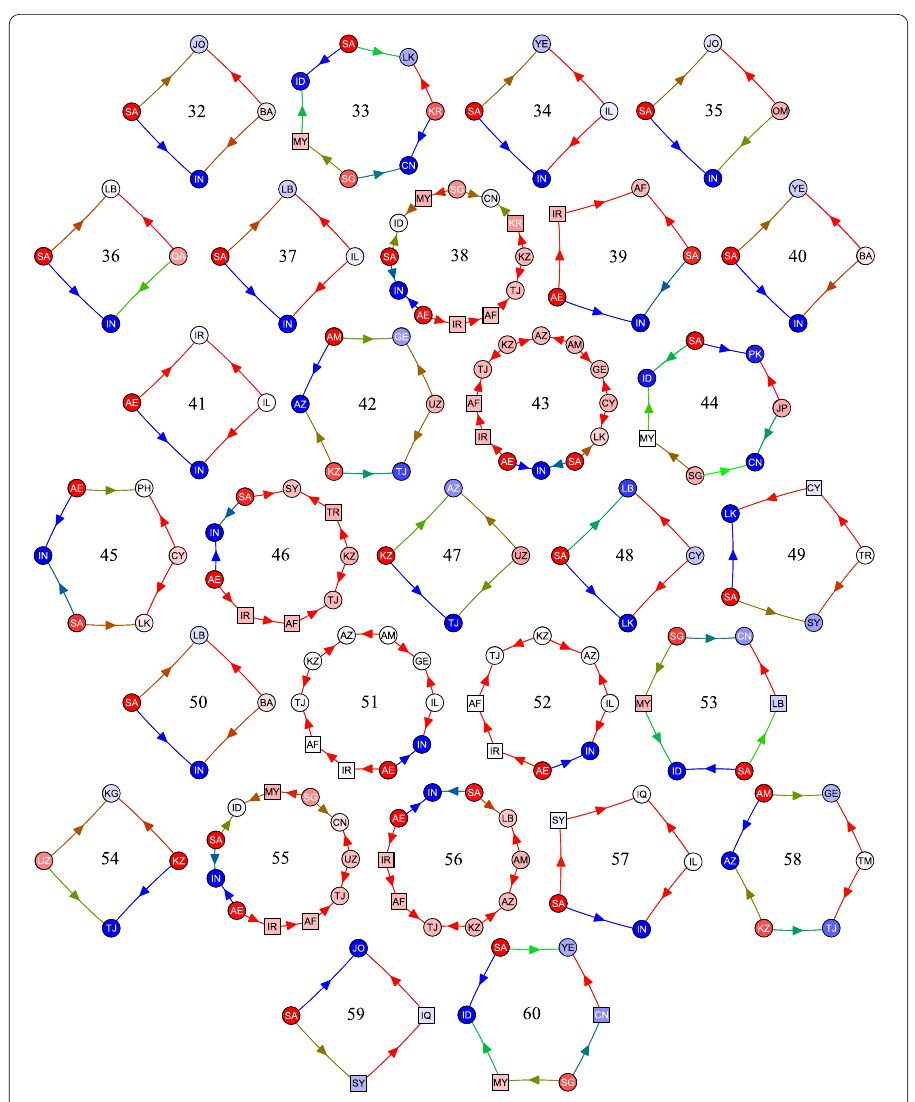
Figure 19 Persistent remittance cycles. The two most persistent 1-cycles in the Asian net remittance network. ( a ) This Type 2 1-cycle corresponds to the most persistent bar in the 1-dimensional barcode in Fig. 9(b). ( b ) This Type 2 1-cycle corresponds to the second most persistent bar in the 1-dimensional barcode